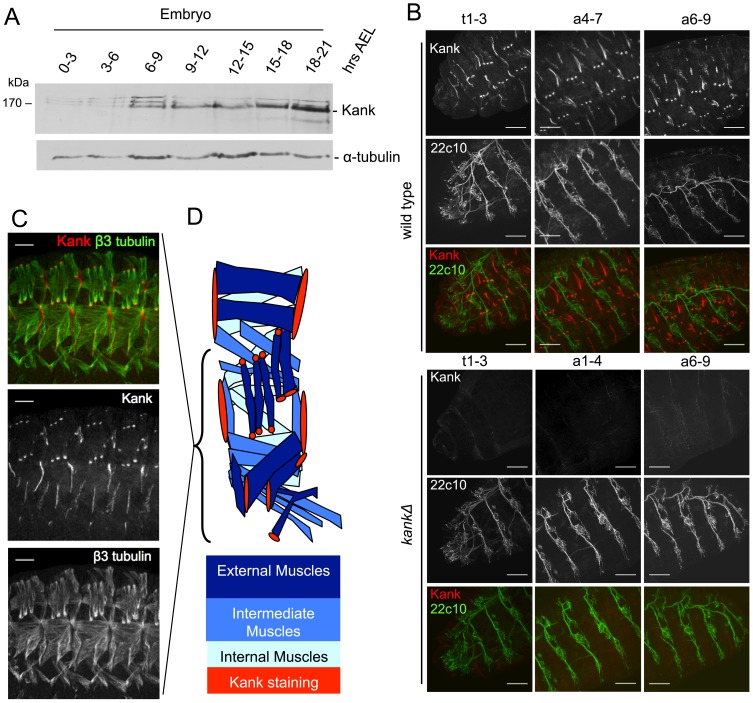
Kank localises to muscle-tendon attachment sites in late stage Drosophila embryos.(A) The ∼160 kDa Kank band was detected in embryos from 3–6 hours after egg laying (AEL). The amount of Kank detected by immunoblotting was observed to increase during embryonic development. The ∼140 kDa band becomes apparent 15–18 hours AEL. (B) An antibody against Kank(489–900) stained a distinct pattern in stage 16/17 embryos. This staining was not observed in kank deletion mutants. The 22c10 antibody, which highlights neurons, was used to orient embryos. (C) β3-tubulin staining reveals the structure of microtubules in somatic muscle cells. Co-staining with the Kank antibody showed that Kank localises at sites of muscle attachment to the epidermis. (D) A schematic of Drosophila embryonic somatic musculature with sites of Kank staining indicated. Scale bars = 25 µm.